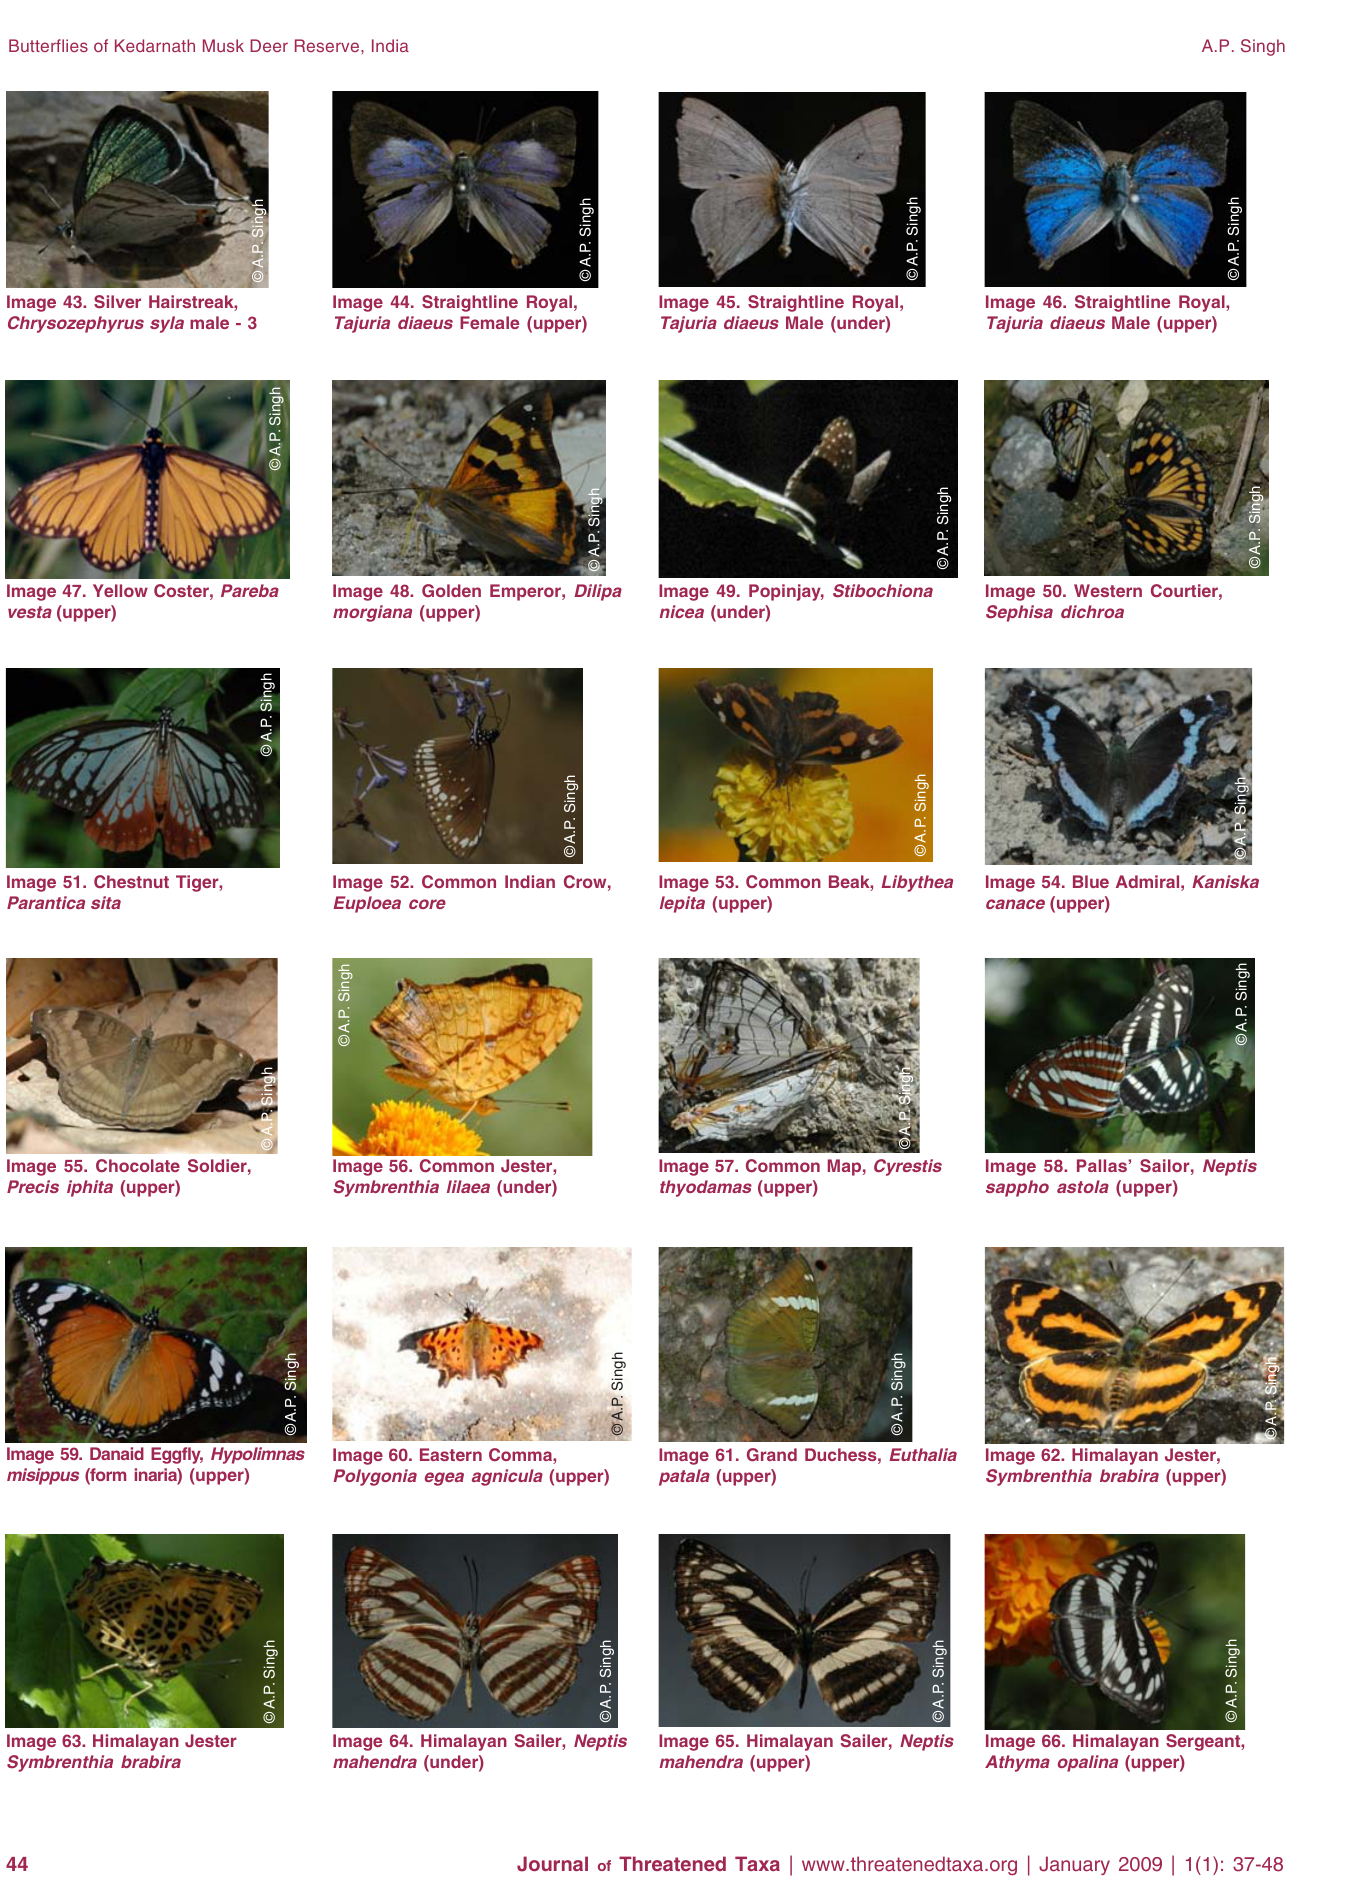
Image 63. Himalayan Jester Symbrenthia brabira